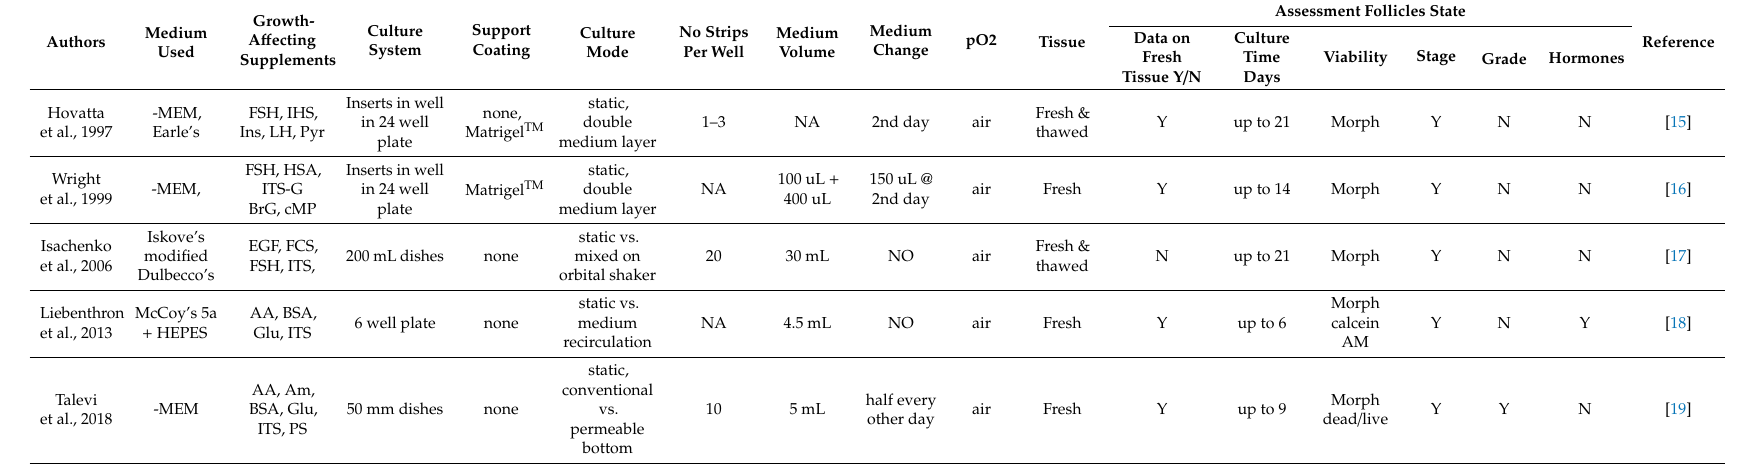
Culture conditions in the literature reports analyzed in this